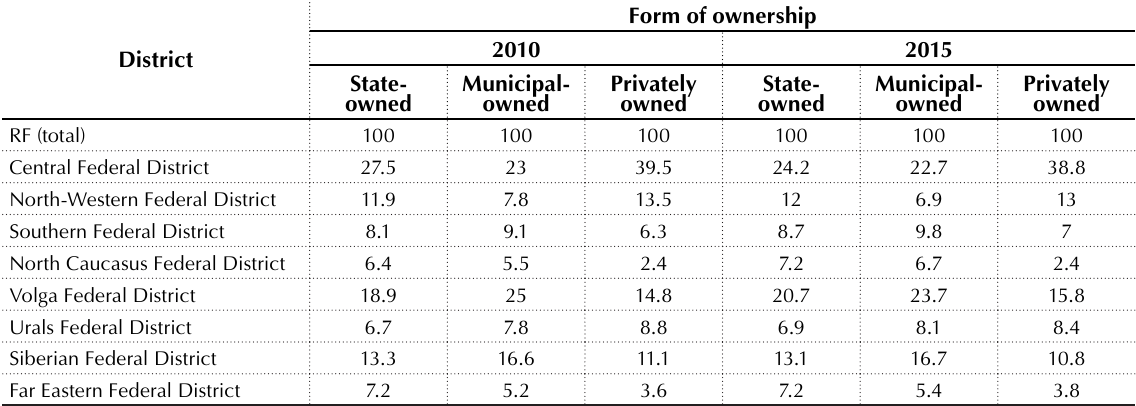
Table 4. Distribution of enterprises and organizations by forms of ownership (%) Source: Calculated according to regions of Russia. Socio-economic indicators,